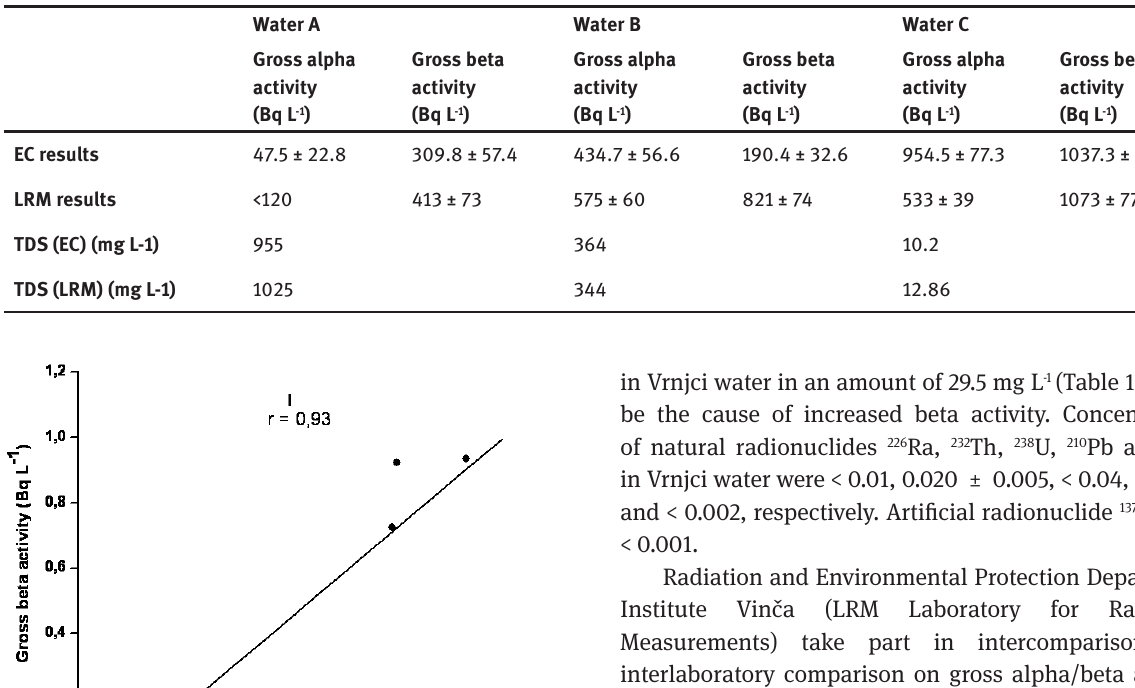
Table 3 : Results of participation in an intercomparison